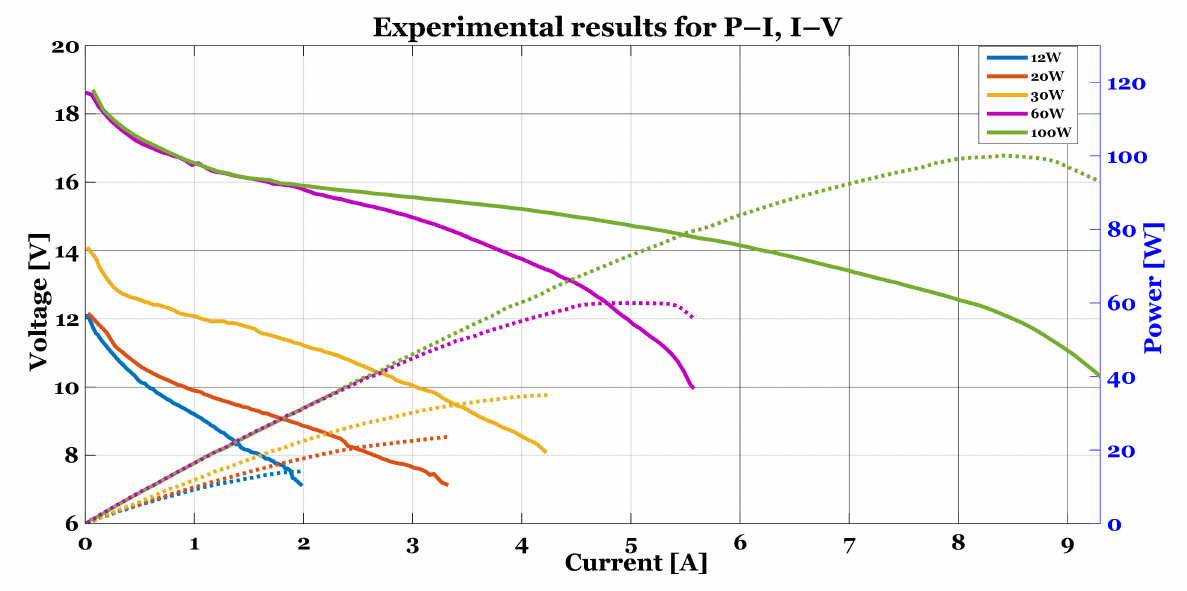
Figure 8. Experimental results for P–I,